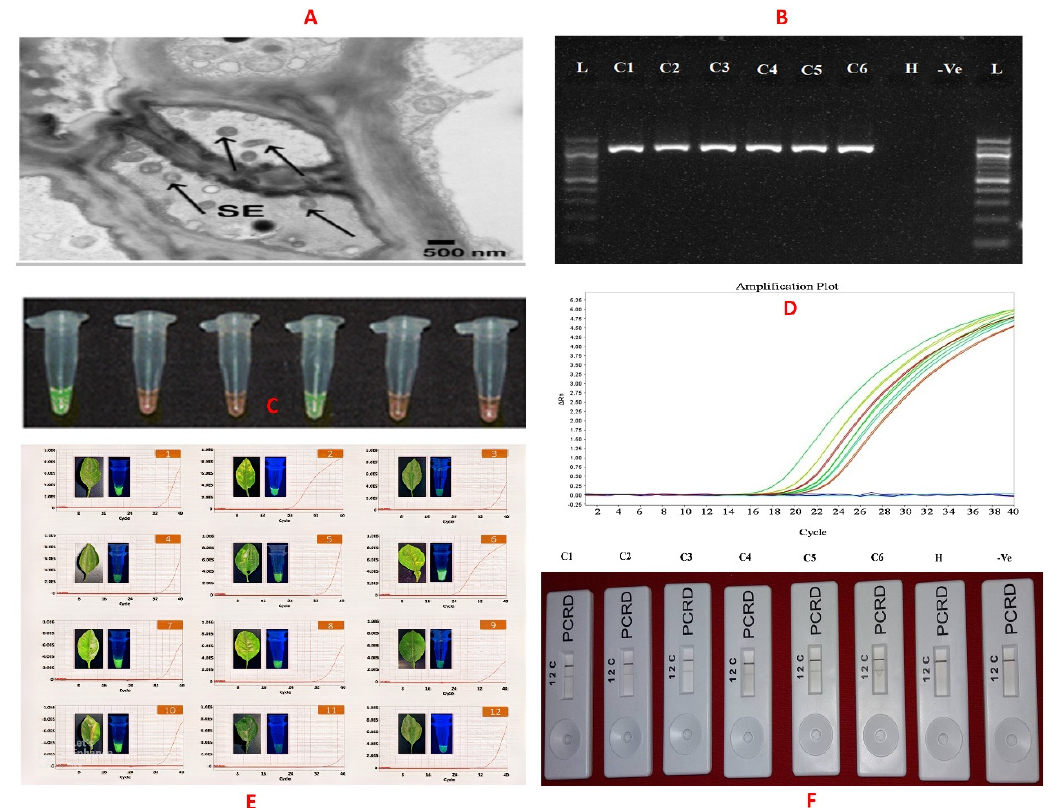
Figure 4. Different methods of C Las detection. ( A ) Transmission electron micrographs of C Las in a sieve element of a young leaf [115]. ( B ) PCR products visualized on agarose gel using primer set OI1/OI2C [L: 1kb DNA ladder, C1 to C6: greening-infected samples, H: healthy control, − Ve: negative control [114]. ( C ) LAMP-based detection using CYBR green I dye under normal light [tubes 1 and 3: greening-infected samples, tubes 2, 3, and 5: healthy control, and tube 6: non-template control [112]( D ) TaqMan-qPCR with HLBas-F/R-HLBp primer probe pair. Amplification plot for sample C1 to C6 represent the C La s -positive sample. ( E ) HLB-positive leaf samples and their detection results by real-time PCR and RPA-based visual detection method [113]. ( F ) HLB-RPA-LFA [C1 to C6 represents the C Las isolates, H: Healthy control and − Ve: negative control [114].